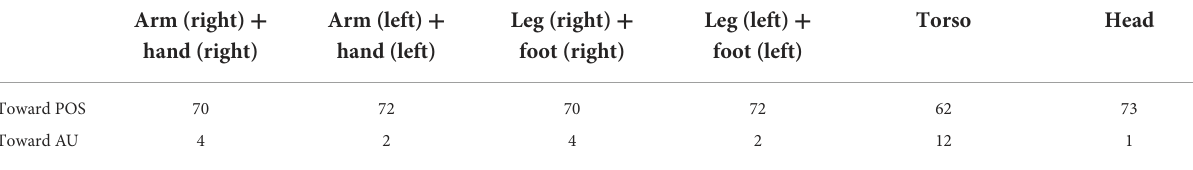
TABLE 6 Projection structure of all articulators with respect to torso direction.